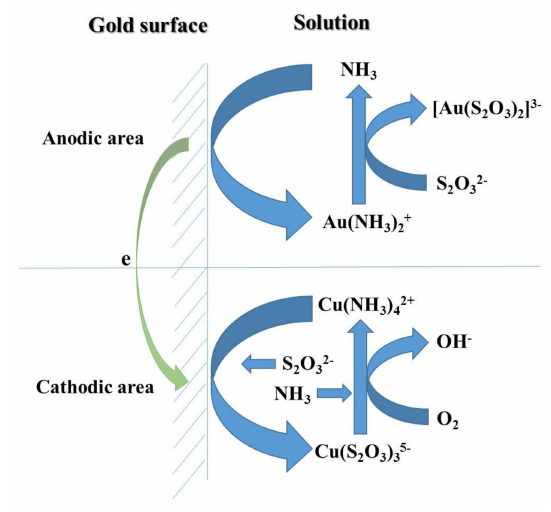
Figure 1. Sketch map of the electrochemical-catalytic mechanism of thiosulfate